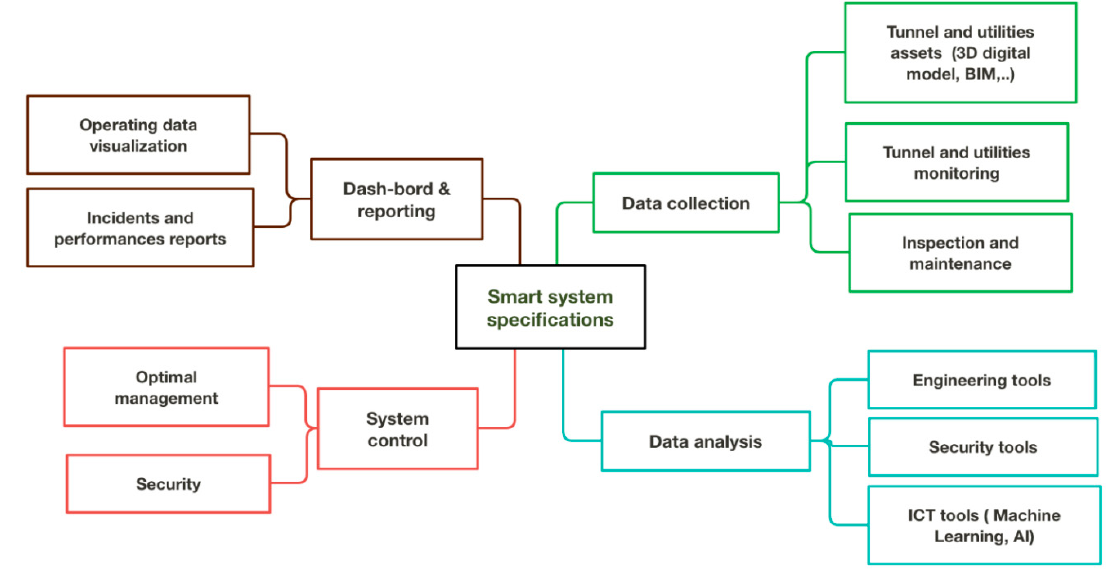
Figure 3. Specifications of the utility tunnel smart system.